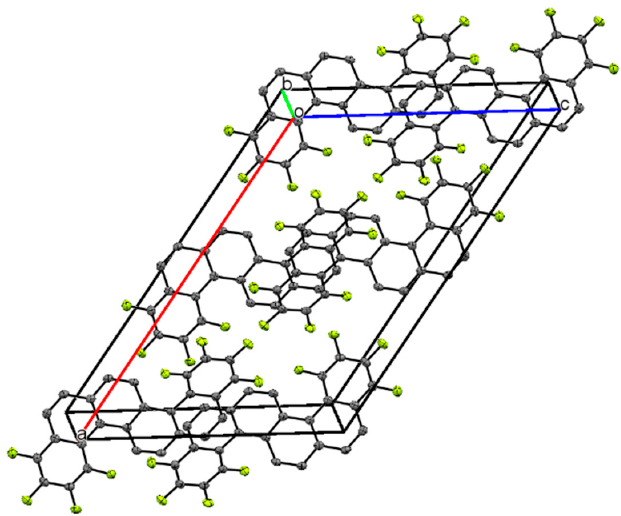
Figure 3. Molecular packing of the compound 4a and thermal ellipsoids are drawn on 50% probability level. Pale green ellipsoid represents F atoms.